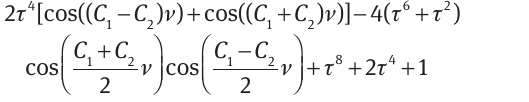
Figure 3: Minimum detectable wavelength shift of Vernier sensor per FSR in function of fraction of the FSR used and number of points used in